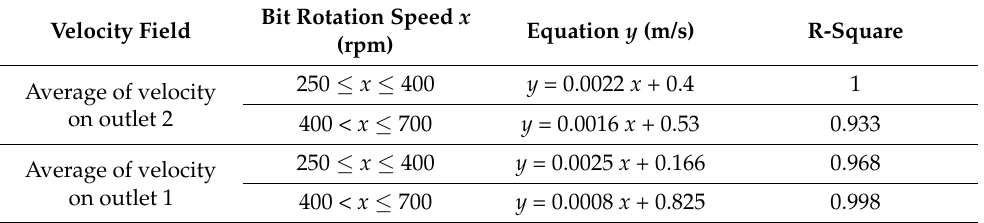
Table 4. The regression equation for the velocity field of up-return drilling fluid at the bottom hole.